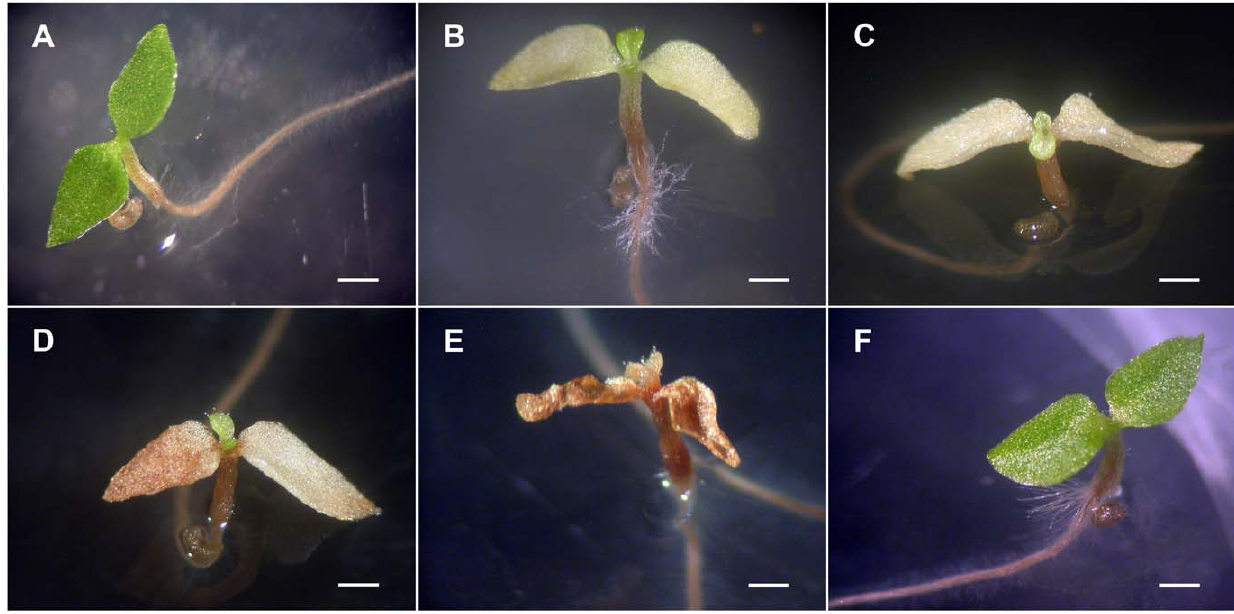
Figure 2. Lethal symptoms observed in hybrid seedlings from reciprocal crosses between N.ingulba and N.tabacum . When hybrid seedlings from the cross N. ingulba 6 N. tabacum ‘Red Russian’ were cultured at 28 u C, the hypocotyl and roots turned brown 6 days after germination (DAG) (A). The cotyledons turned yellow at 20 DAG (B), and brown at 26 DAG (C). The young true leaves and shoot apices were still green at 43 DAG (D), but the seedlings turned completely brown and died at 51 DAG (E). Hybrid seedlings from the reciprocal cross ‘Red Russian’ 6 N. ingulba showed similar symptoms, browning of the hypocotyl and roots, at 13 DAG at 28 u C (F). Scale bars=1 mm.